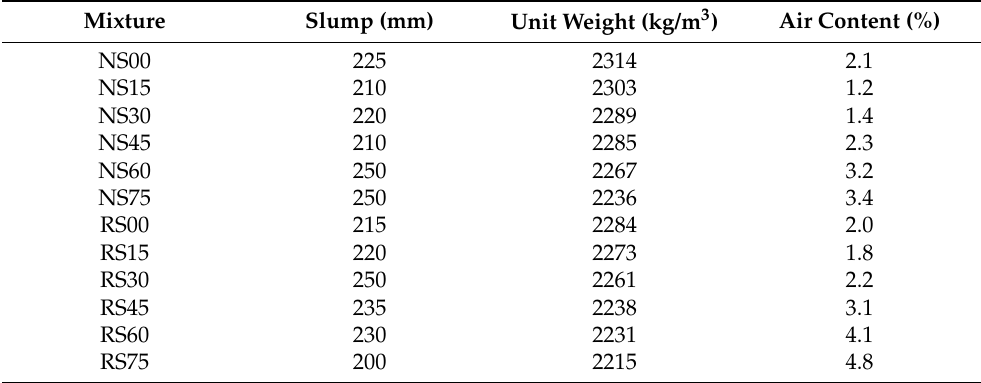
Table 3. Properties of fresh